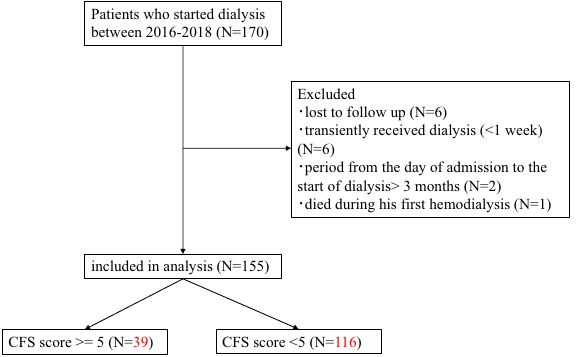
Figure 1. Chart showing flow of the study.